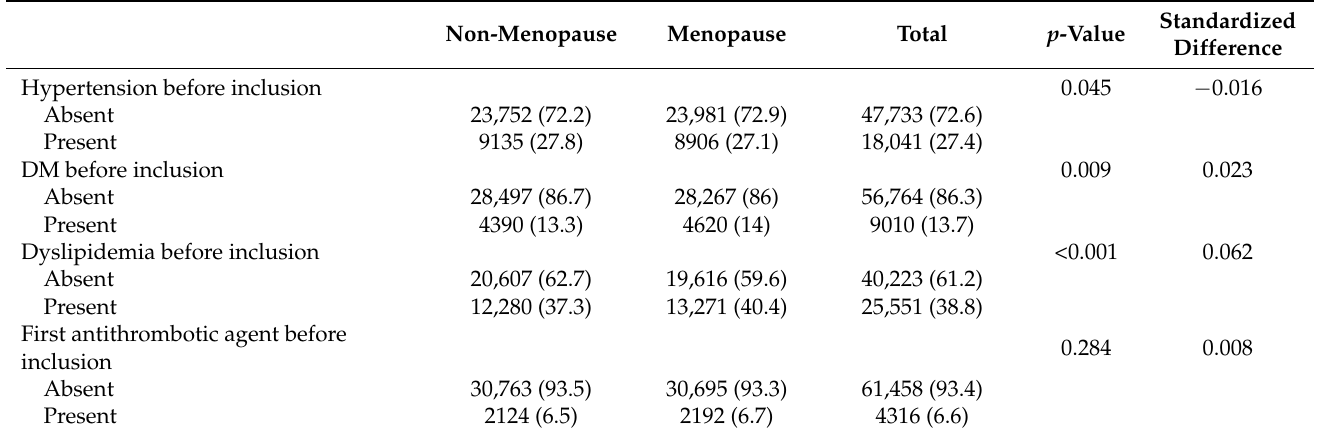
Table 3. Odds ratios for risk of age-related macular degeneration according to menopause after